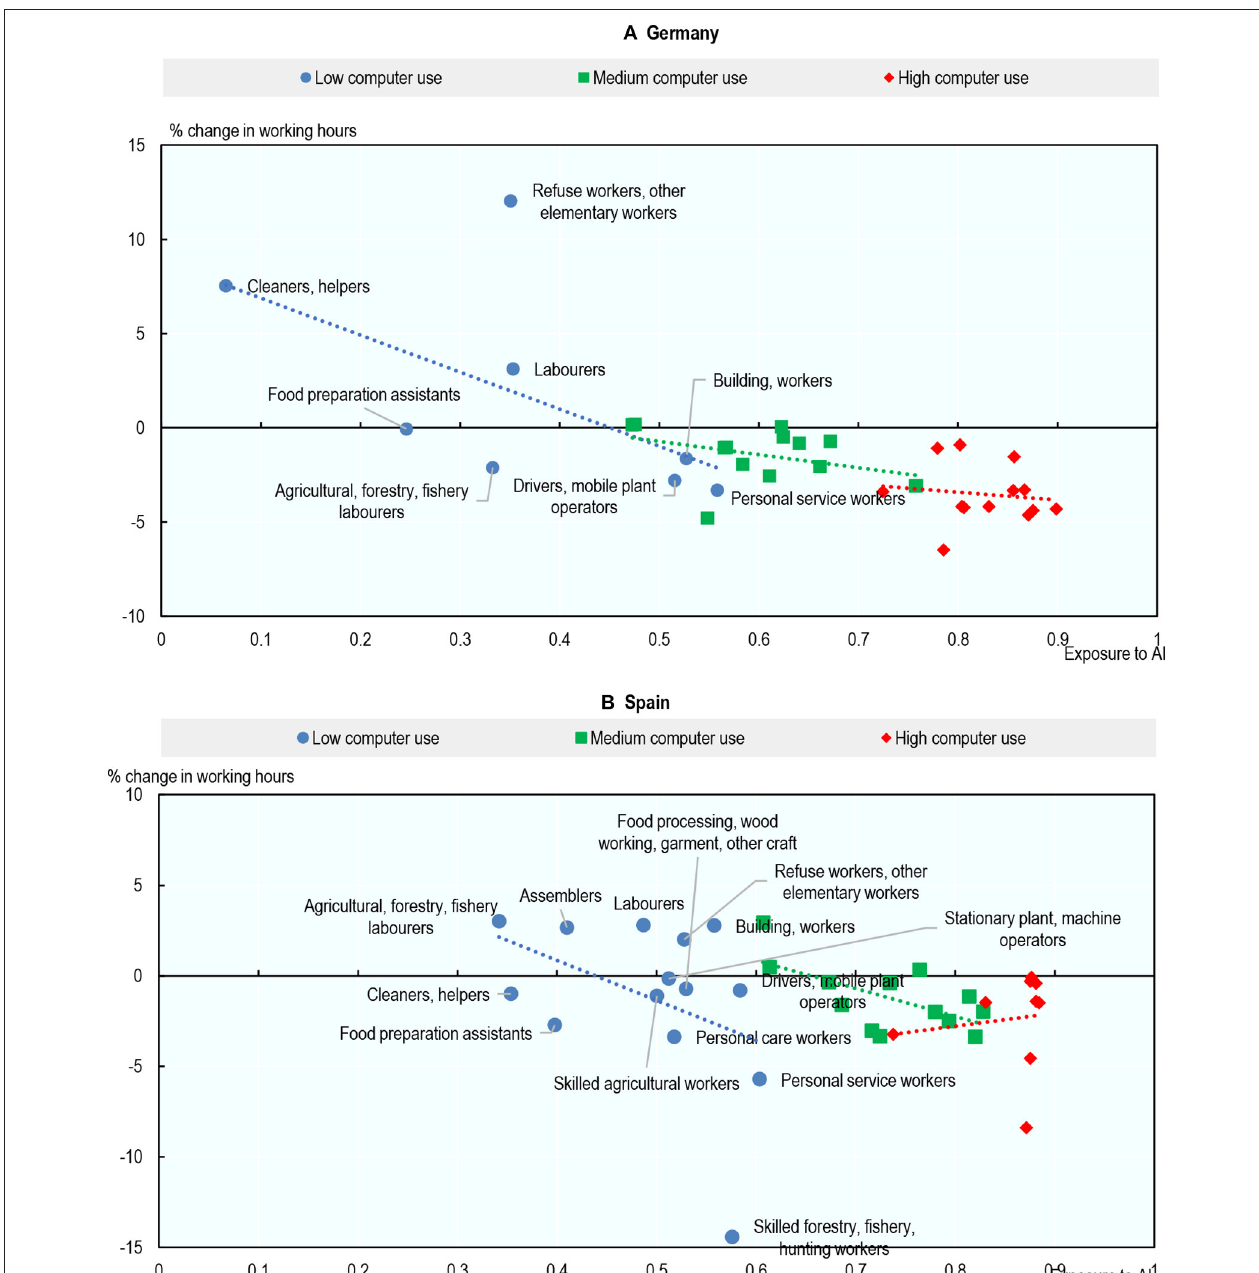
FIGURE 14 | In occupations where computer use is low, exposure to AI is negatively associated with the growth in average working hours. Percentage change in average usual working hour (2012–2019) and exposure to AI (2012). Occupations are classified using two-digit ISCO-08. Not all occupations have marker labels due to space constraints. Occupation-country cells are classified into low, medium or high computer use by tercile of computer use applied across the full sample of occupation-country cells. Source: Author’ calculations using data from EU-LFS, PIAAC, and Felten et al. (2019). (A) Germany and (B) Spain.